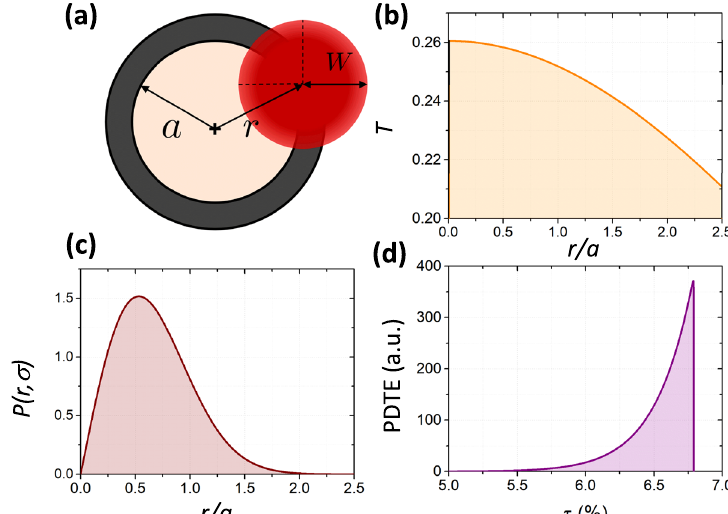
Fig. 2 Channel characterization. Example of the characterization of an atmospheric channel at a fi xed satellite-to-ground slant distance of R = 400 km. The values for the variables are θ p = 1 μ rad, θ d = 10 μ rad, a = 0.75 m. a Schematic of the beam and receiver telescope aperture. b Transmission coef fi cient as a function of the de fl ection distance. c Probability distribution of the de fl ection distance. d Probability distribution of the transmission ef fi ciency